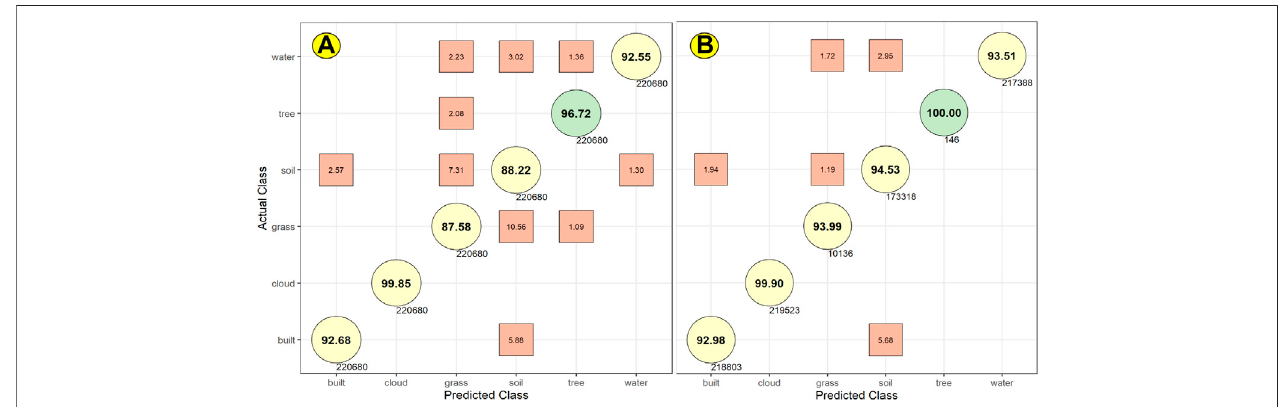
FIGURE 8 | These Confusion Matrices are based on results from Random Forest tests for two different types of data (see Table 2 ). In (A) , we estimated accuracy scores based on all the test data derived from the 120 iterations we ran of Random Forest. In (B) , we selected pixels that were classi fi ed consistently across at least 10 iterations.